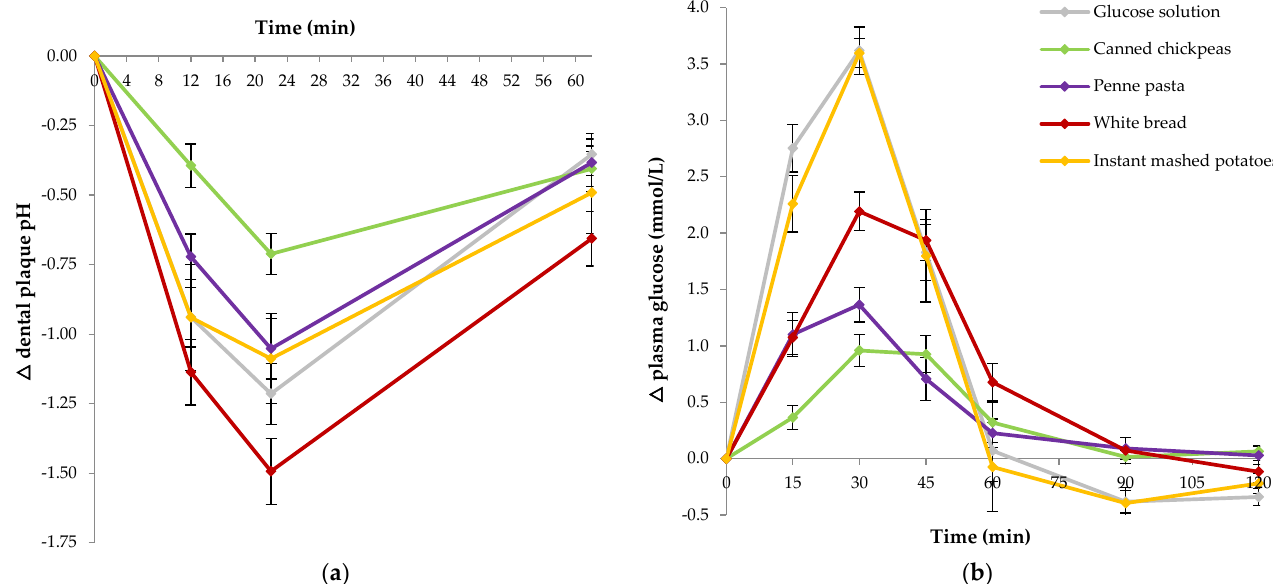
Figure 2. Impact of 25 g available carbohydrate portions of different carbohydrate foods, varying in GI, on dental plaque pH in 12 healthy participants ( a ) Change in postprandial dental plaque pH over 62 min; ( b ) Change in plasma glucose concentration over 120 min. Data are mean ± standard error mean (SEM), n = 24 for the two repeated glucose solution tests (shown in grey), and n = 12 for each of the four test foods: canned chickpeas (shown in green), penne pasta (shown in purple), white bread (shown in red) and instant mashed potatoes (shown in yellow).